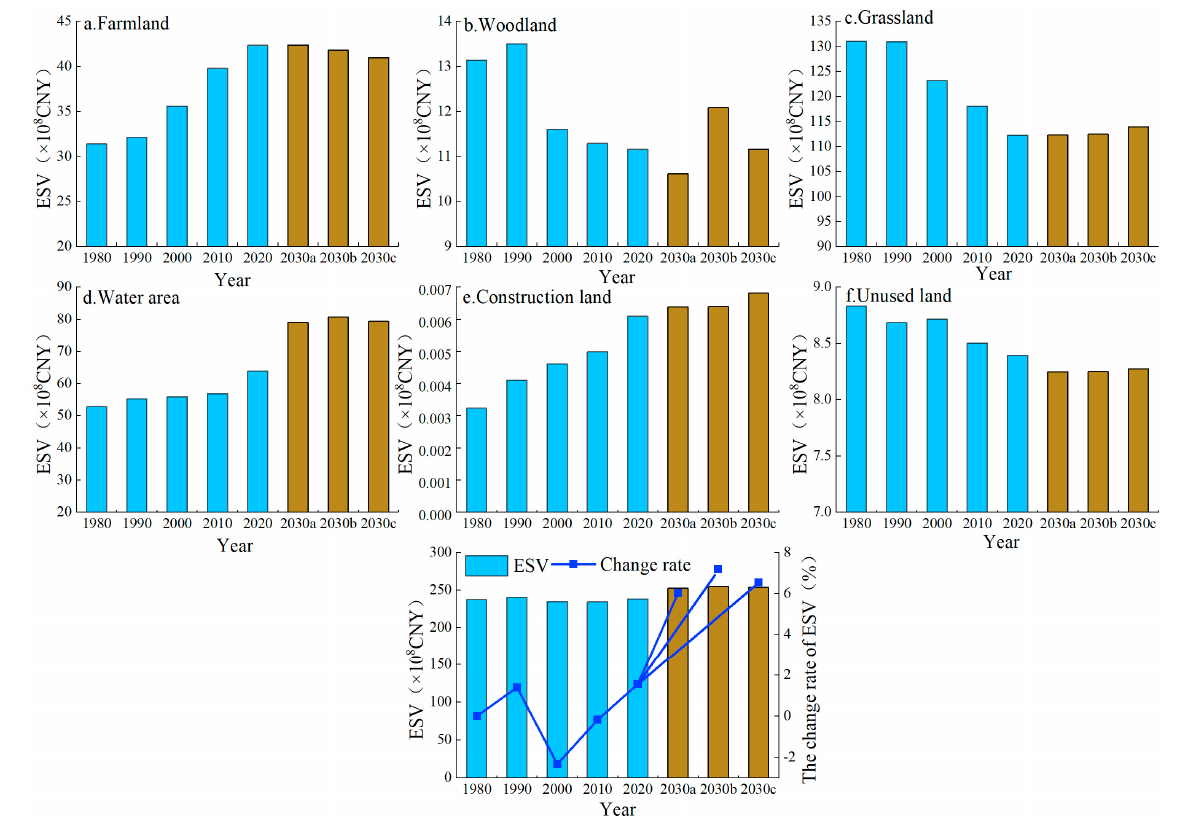
Figure 6. ESVs for LULC types in the Manas River Basin from 1980 to 2030.(Note: a, b, and c indicate ND, EPD, and EED scenarios, respectively).